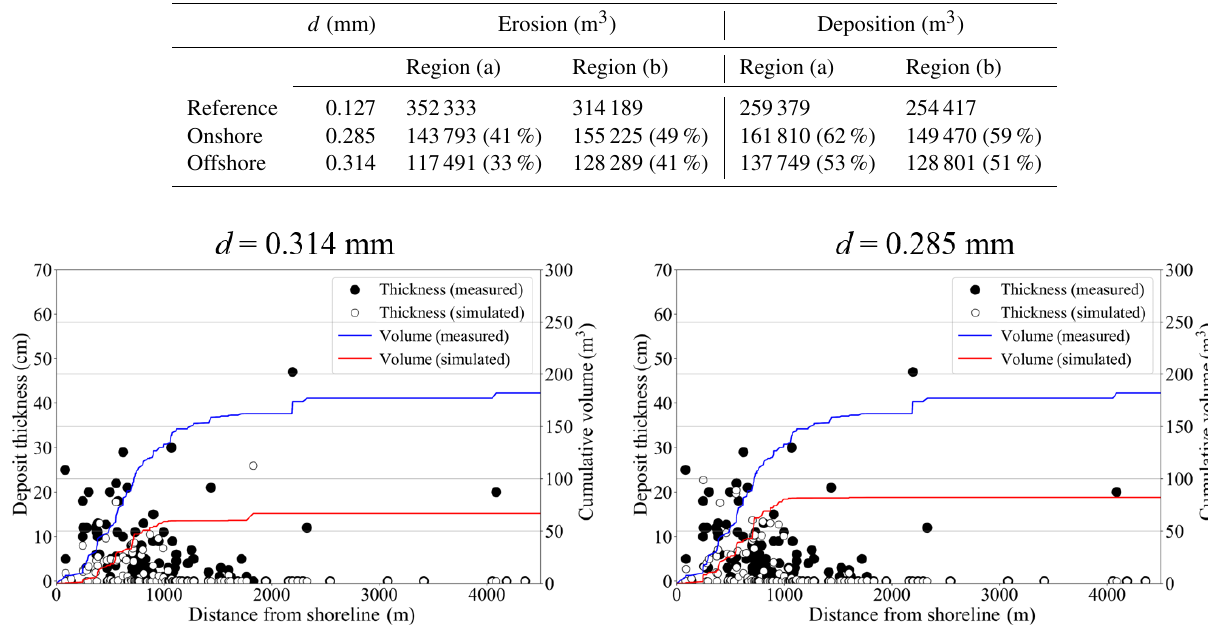
Figure 10. Comparison of field-measured and simulated tsunami deposit thickness for each grain